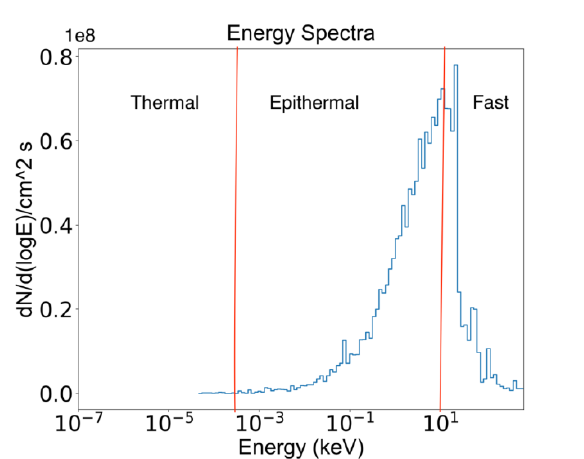
Fig. 11. Neutron spectrum at beam port of the optimized